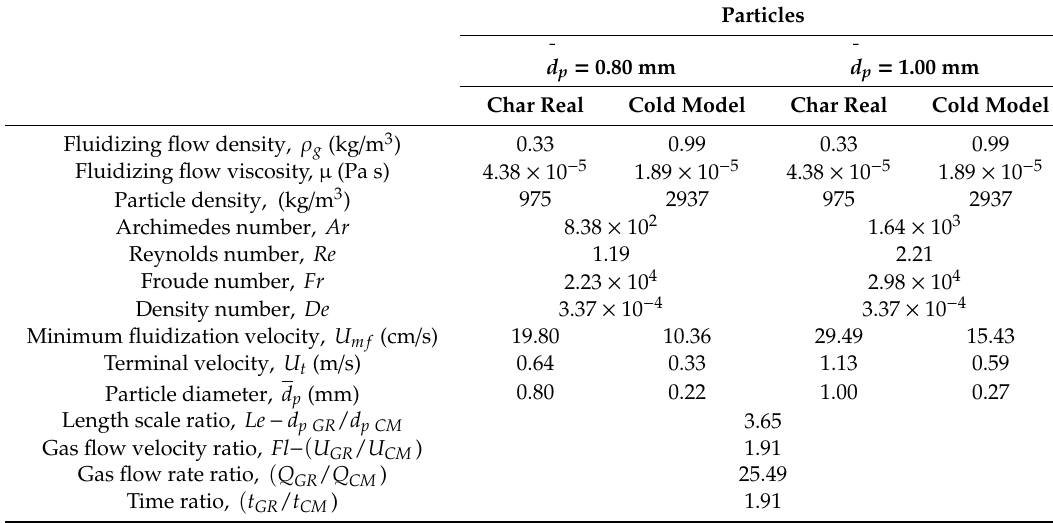
Table 3. Similarity of fluid dynamic for char particles inside cold